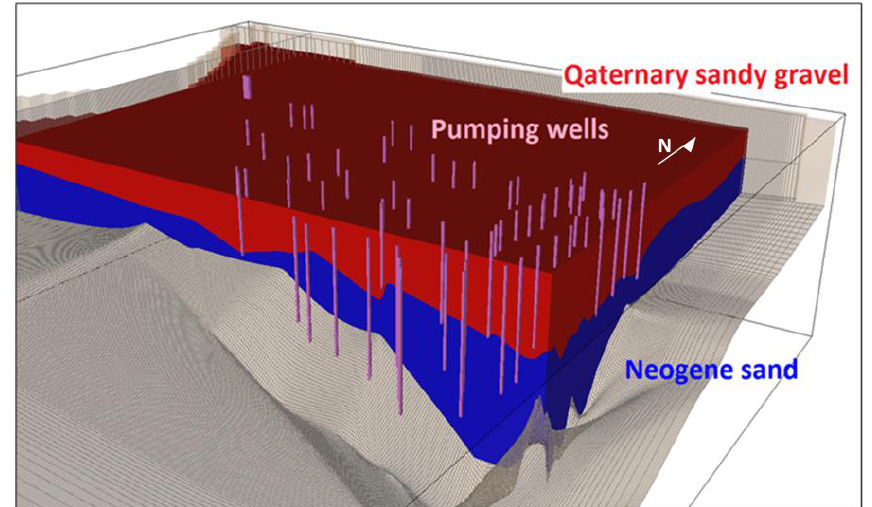
Figure 2. Block diagram of geological settings with the principal aquifer layers and pumping wells depiction (vertical exaggeration 1:20).